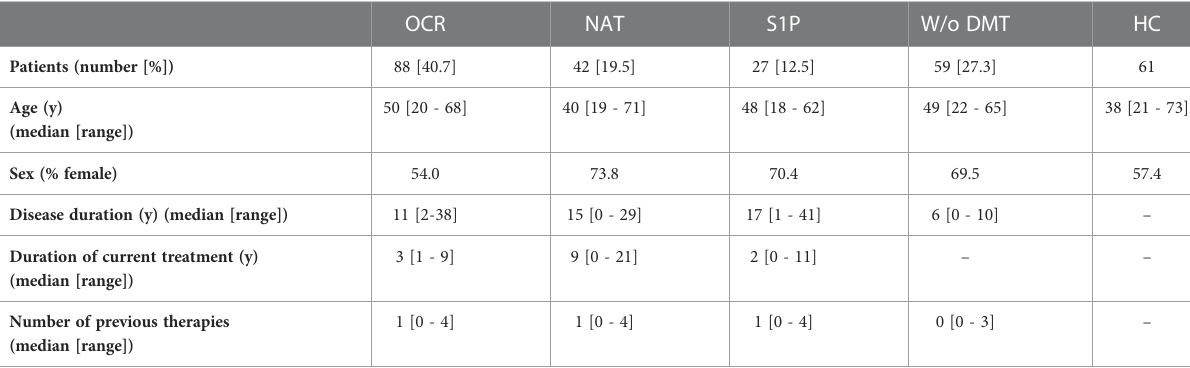
TABLE 2 - Demographics and basic disease characteristics.